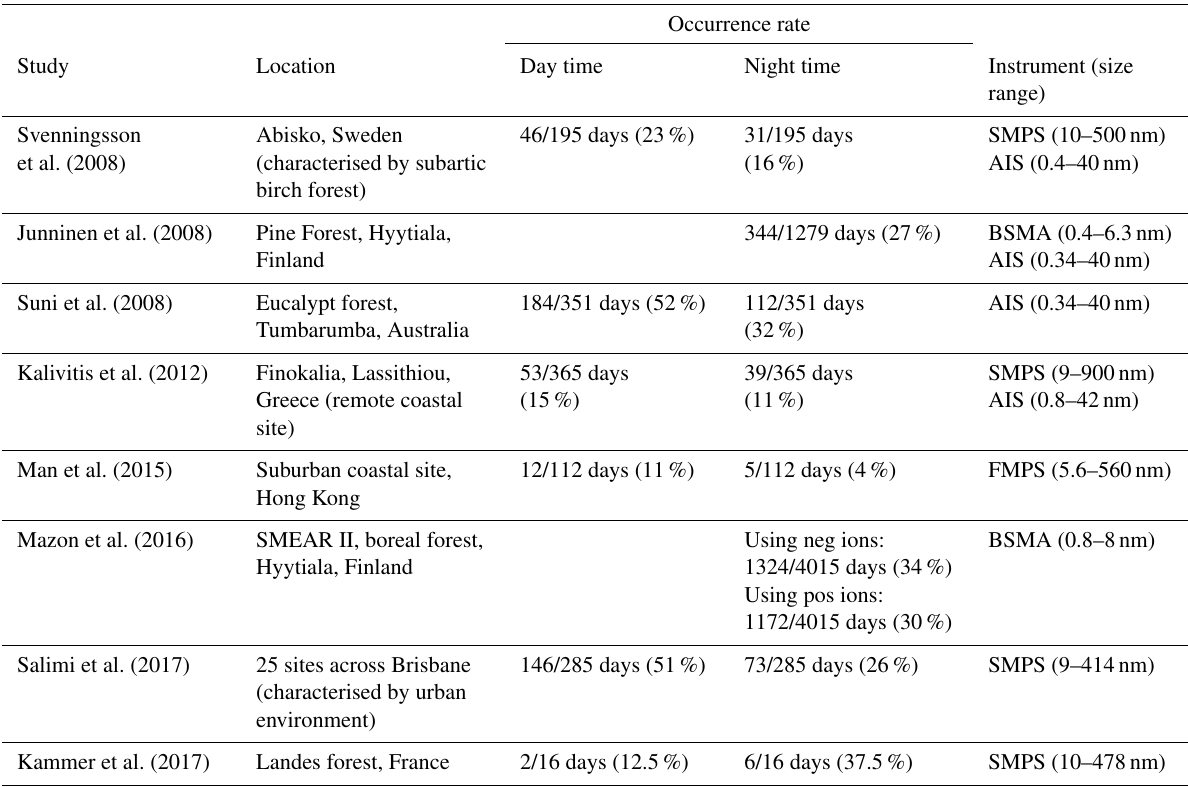
Table 1. Summary of studies reporting night time NPF events: scanning mobility particle sizer (SMPS), air ion spectrometer (AIS), balanced scanning mobility analyser (BSMA), fast mobility particle sizer